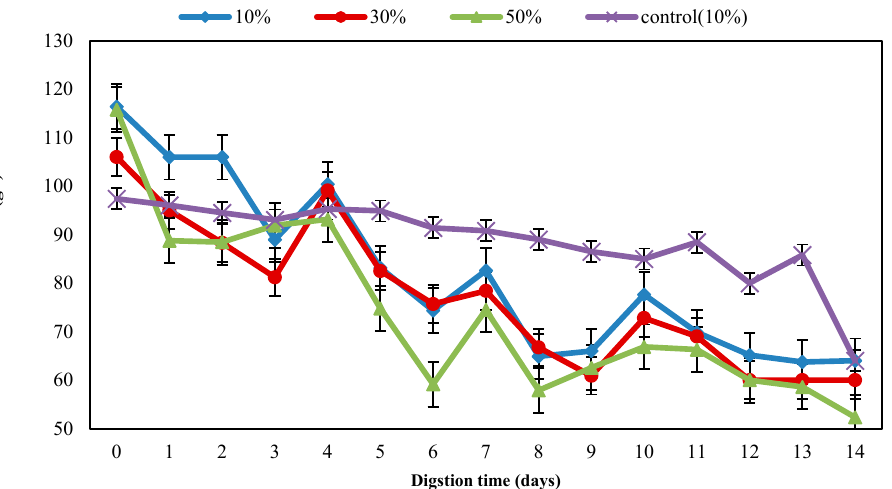
Figure 12. TVS content in the digesters with different inoculum-to-feed ratios with digestion time of 14 days.